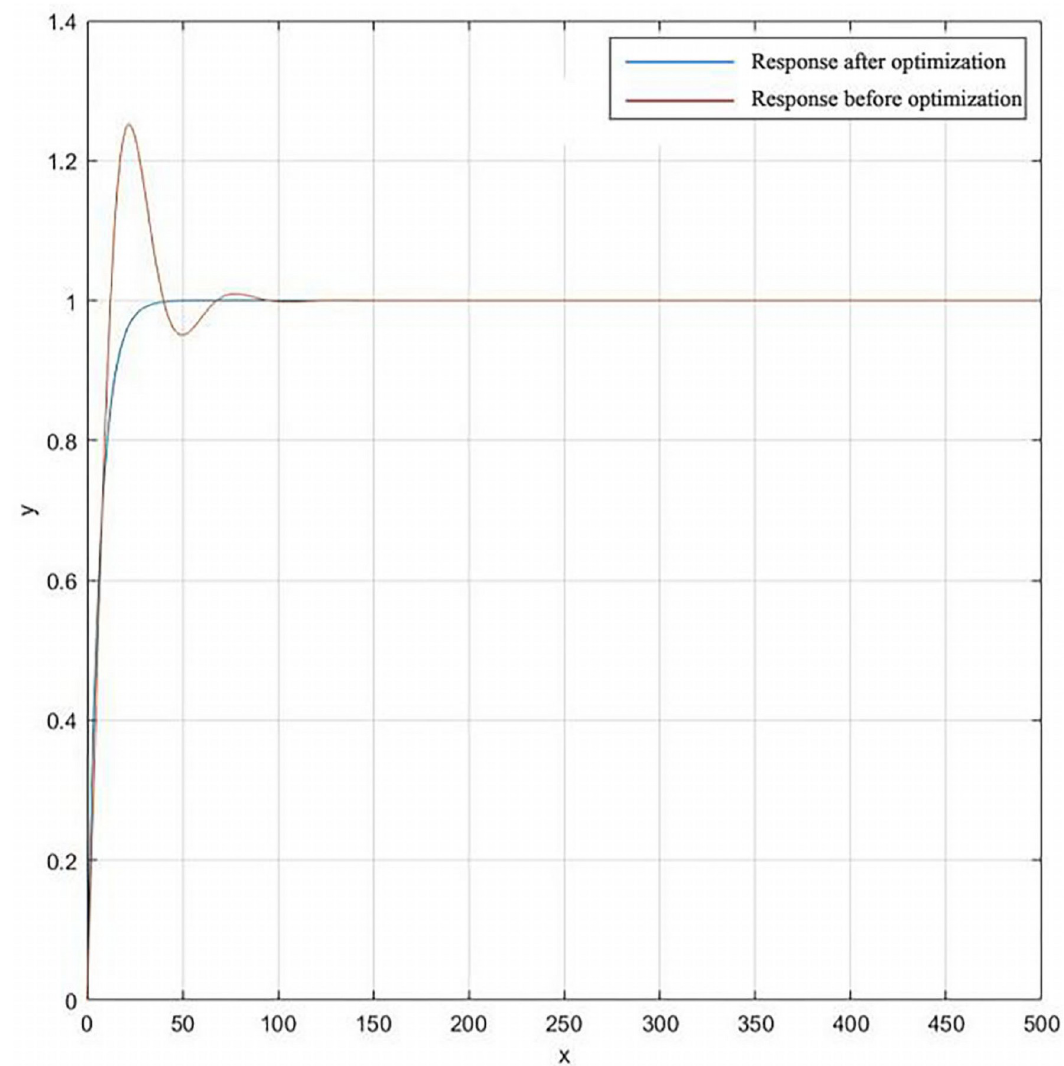
Fig 16. Step response simulation diagram of PID